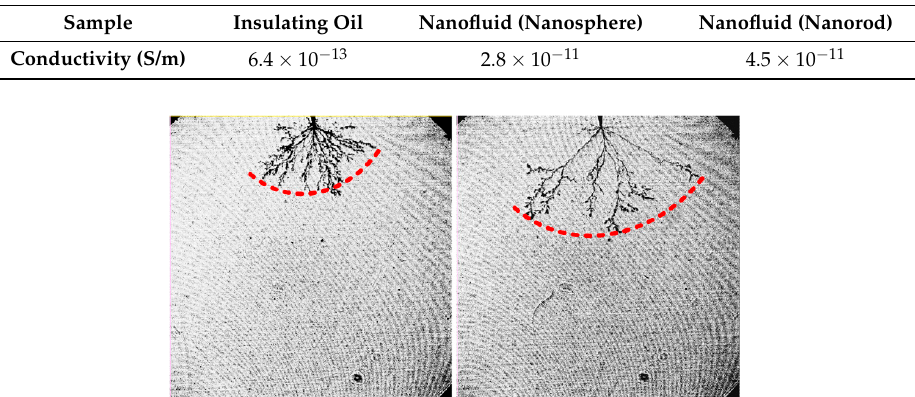
Table 2. Conductivity of insulating oil and TiO 2 nanofluids.